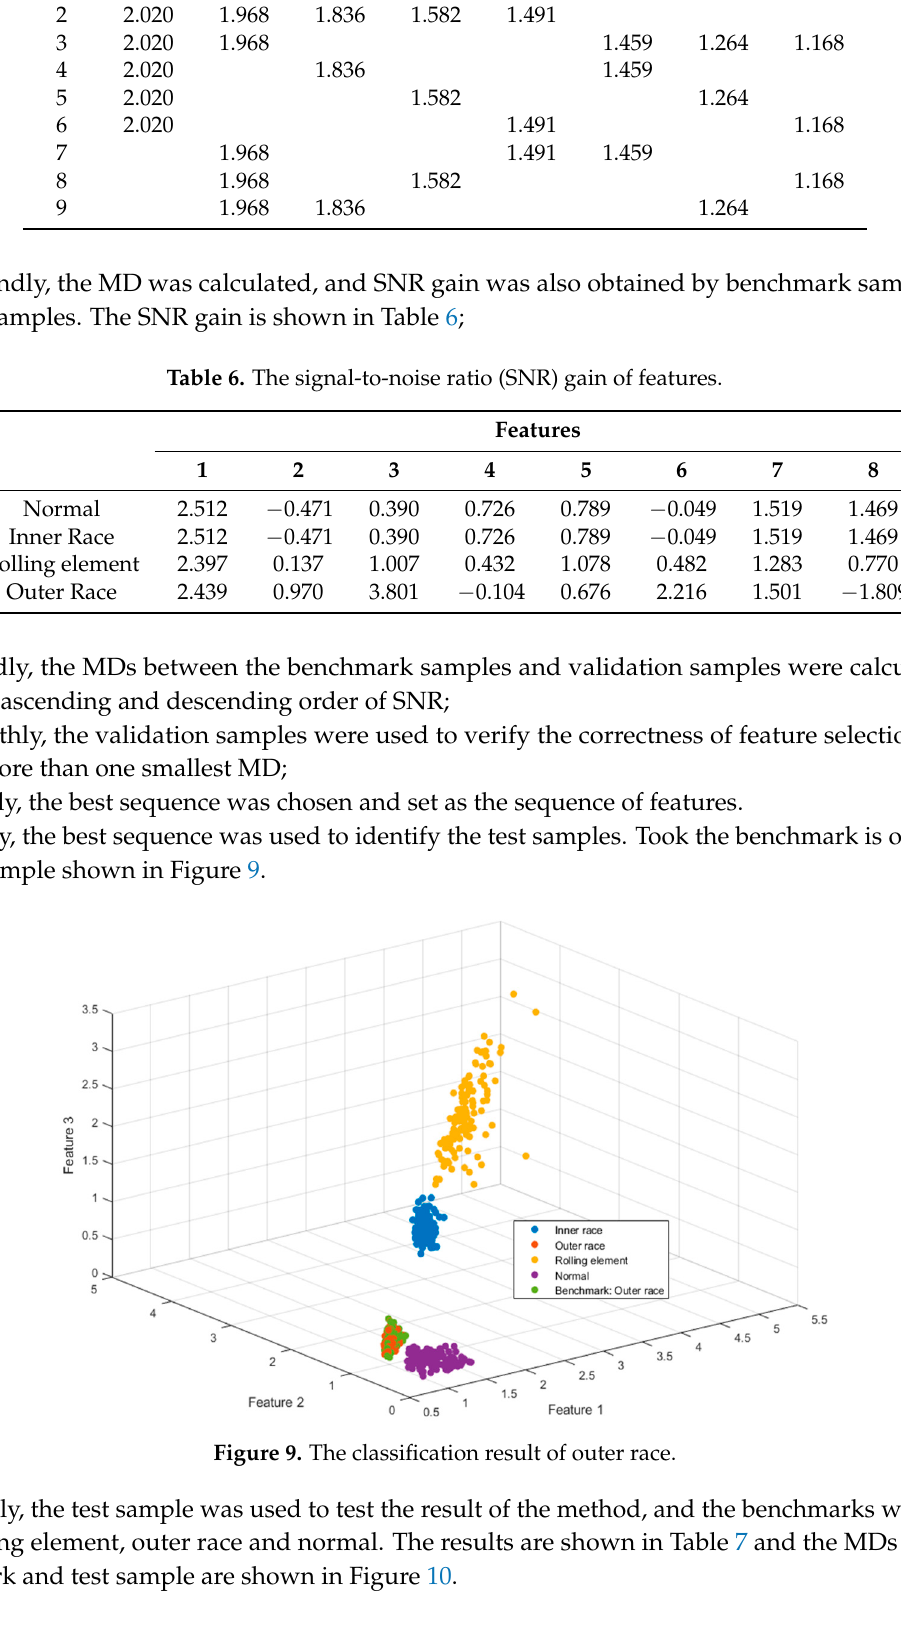
Table 7. The recognition result.